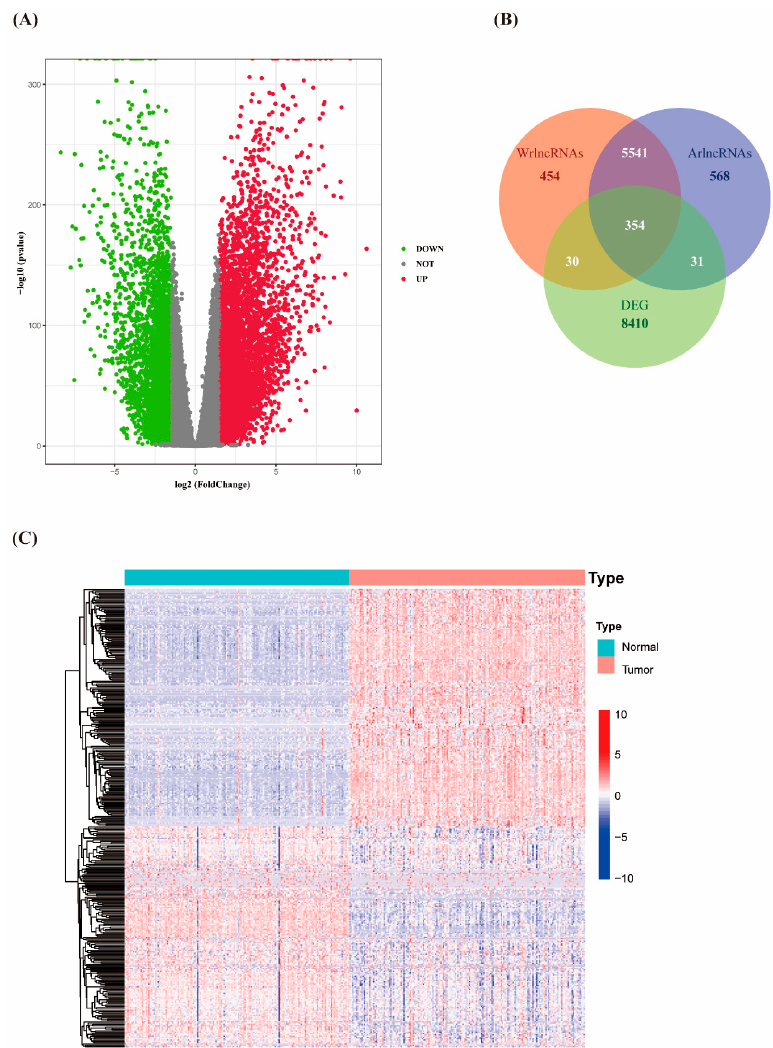
Figure 1. Identification of differentially expressed warlncRNAs in PAAD. ( A ) Volcano plot of DEGs between PAAD and adjacent normal tissue. ( B )Venn diagram of wrlncRNAs, arlncRNAs, and DEGs intersection. ( C ) Heatmap of the expression levels of 354 candidate warlncRNAs.